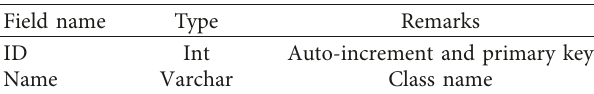
Figure 7: Evaluation process design. Table 1: Class table.